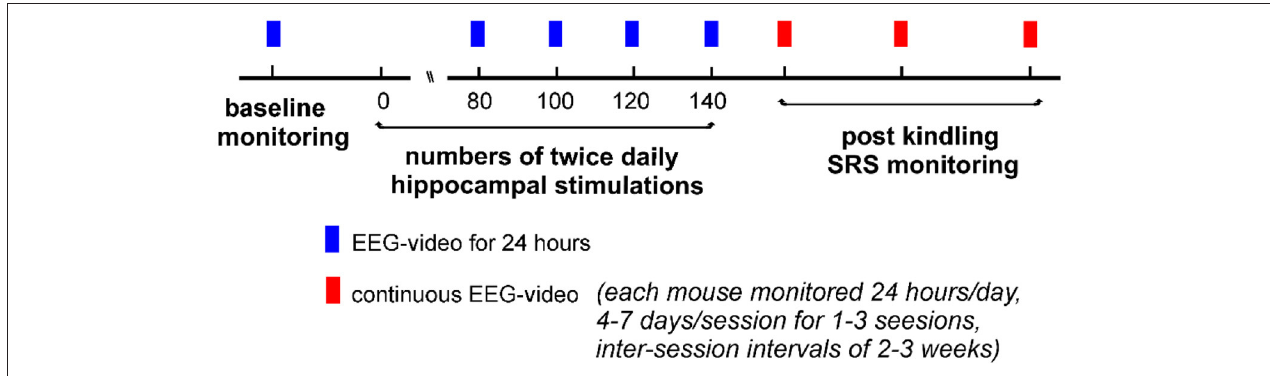
FIGURE 1 | A schematic outline of the experimental protocols. Individual mice experienced twice daily hippocampal stimulations for up to 140 stimulations. Electroencephalogram (EEG)-video monitoring for 24h was performed before and after 80, 100, 120, or 140 stimulations. No stimulation was applied if ≥ 2 SRS events were detected within a single 24-h monitoring period. Continuous 24-h EEG-video monitoring (4–7 days per session) was performed after the termination of kindling stimulation. Similar EEG-video monitoring was repeated 2–3 times if suitable (2–3 weeks apart between